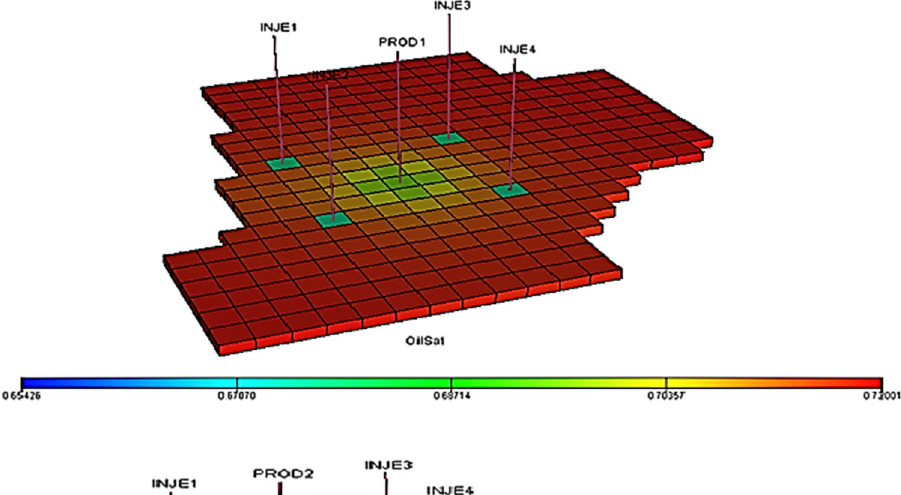
Fig. 11 Map showing the location of wells in the direct line drive waterflood pattern